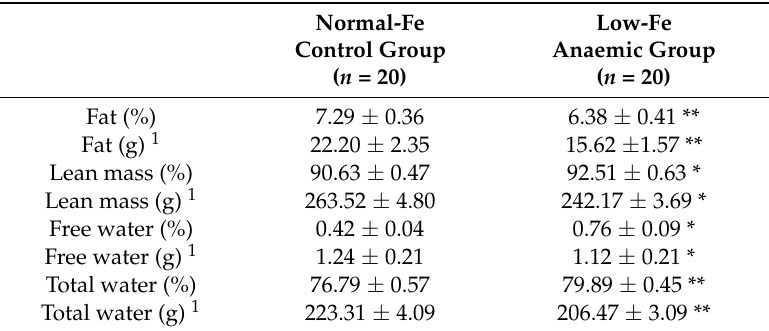
Table 4. Body composition in control and anemic rats.